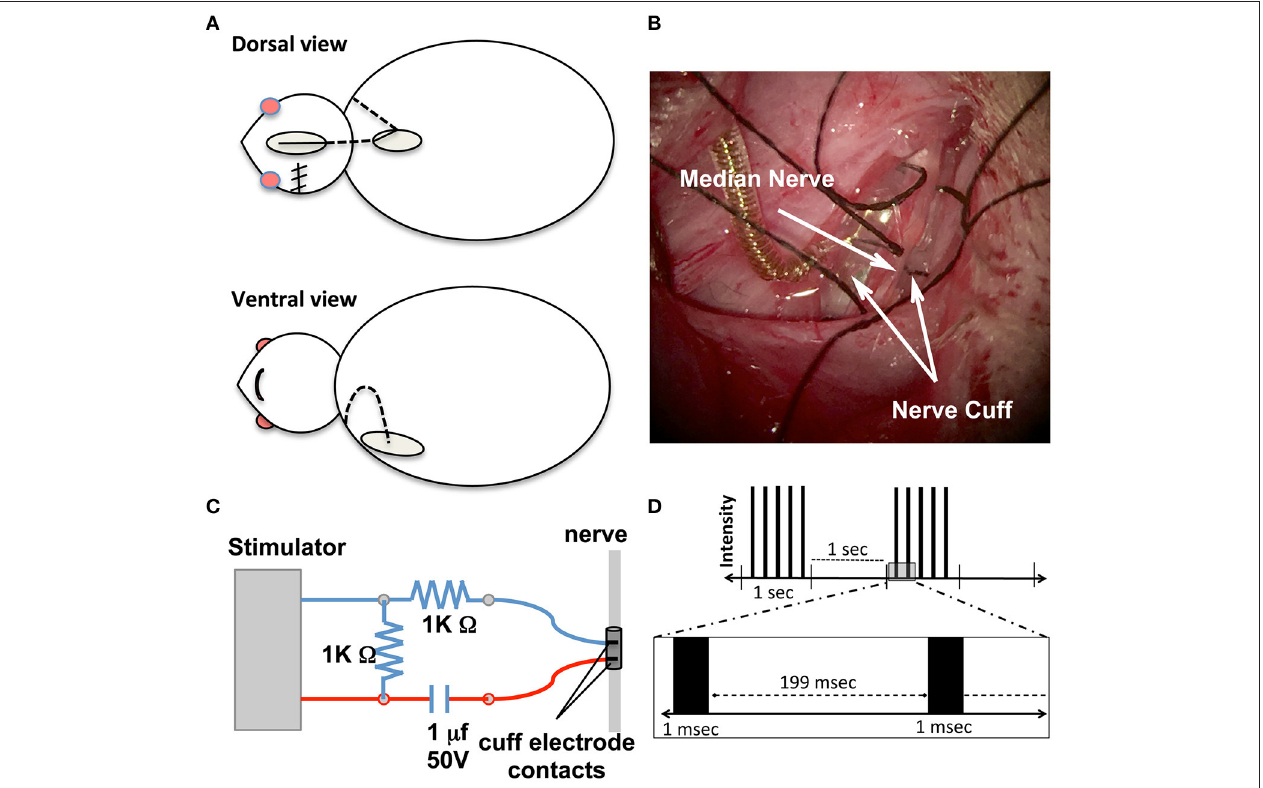
FIGURE 2 | Nerve cuff placement. (A) Schematic of surgical procedures for nerve cuff placement. Dotted lines represent the lead wire and ovals represent surgical incision sites. (B) Intraoperative photographs of the cuff enclosing the nerve according to the experimental design. Gold colored coil is the lead wire leaving the cuff. Black sutures were tied to keep cuff secure around nerve. (C) Schematic diagram of electrical stimulation circuit setups. The stimulator is the power source and (D) Schematic demonstration of stimulation parameters. Each black bar represents an individual pulse